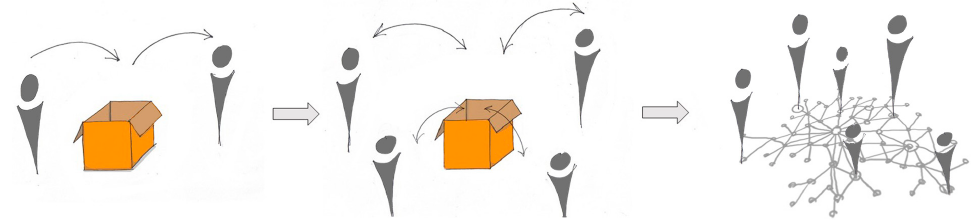
Figure 1. The trasformation of information environments: hierarchical, relational,